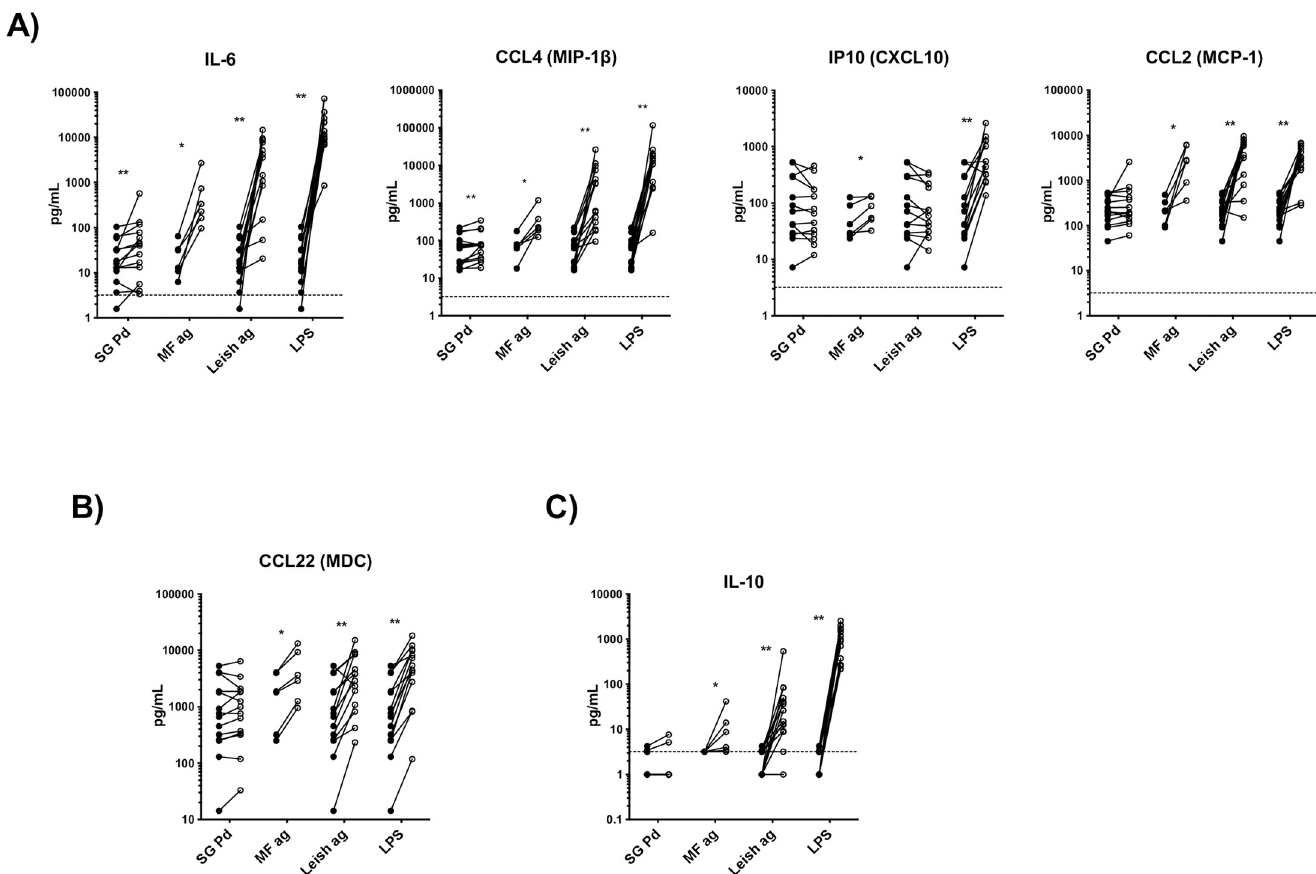
Fig 1. Saliva of the vector sand fly Phlebotomus duboscqi upregulates the production of CCL4 and IL-6 in human monocytes. Human monocytes were unexposed (closed circles) or exposed (open circles) to either saliva of SG Pd, MF ag, Leish ag, or to LPS (positive control) for 24 hours in vitro . Supernatants were collected and the levels of A) Type-1 associated chemokines/cytokines IL-6, CCL4, IP10, and CCL2, B) Type-2 associated chemokine CCL22, and C) regulatory cytokine IL-10 were measured. Each line represents an independent donor ( n = 6–14). Statistical difference in cytokine production between unexposed and exposed cells are measured using Wilcoxon matched pairs signed-rank test; � ( p < 0.05); �� ( P < 0.005).